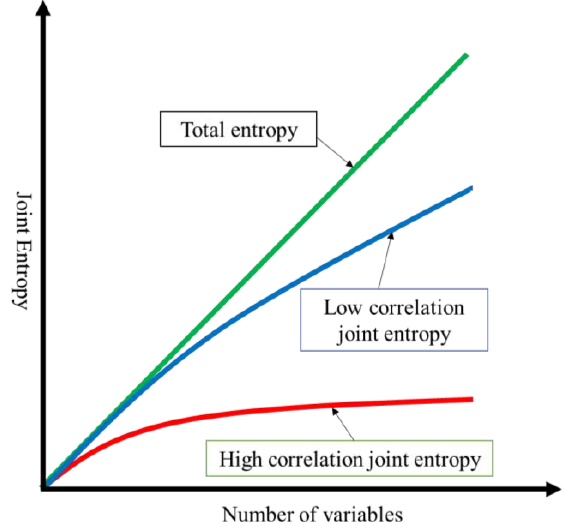
Figure 2. The relation between correlation and joint entropy with different correlational levels.